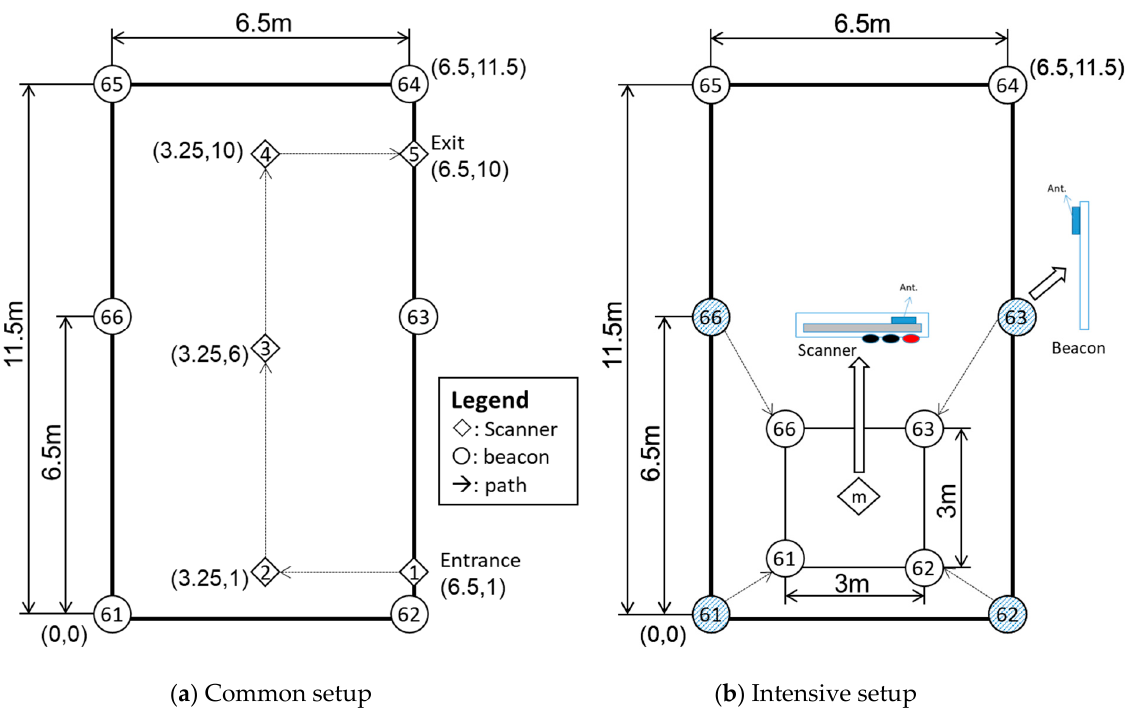
Figure 8. Dimensions of the layout in the multi-beacon scenario.